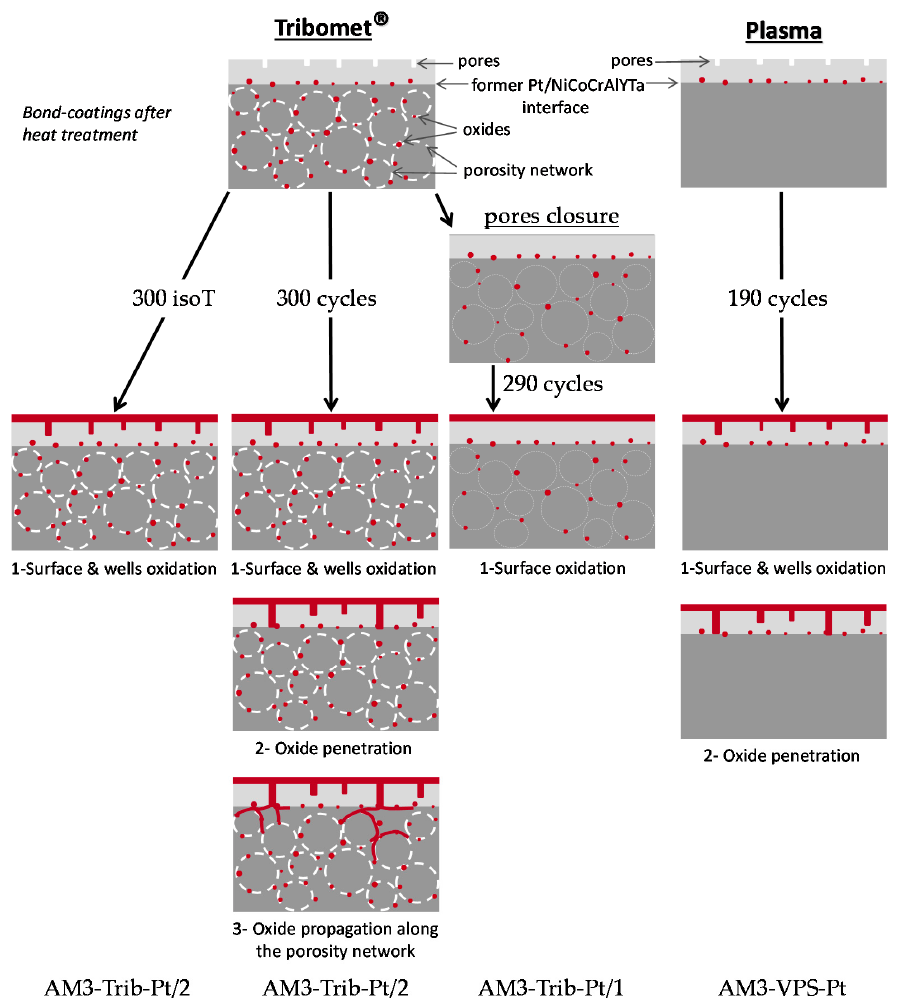
Figure 10. Proposed degradation mechanisms for TBC systems composed of a Pt-modified NiCoCrAlYTa bond-coating.